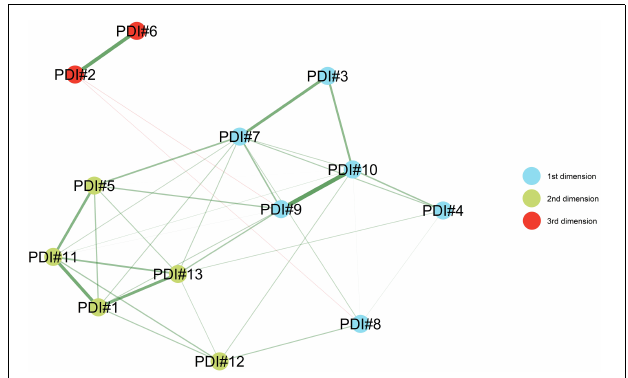
FIGURE 1 | Study 1. Exploratory graph analysis (EGA) of the Psychological Distress